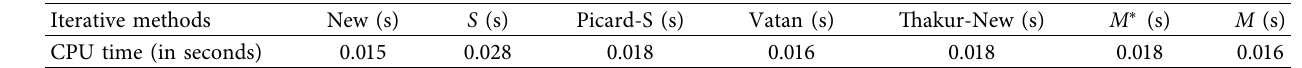
Table 2: A comparison table for the CPU time for convergence of iterative